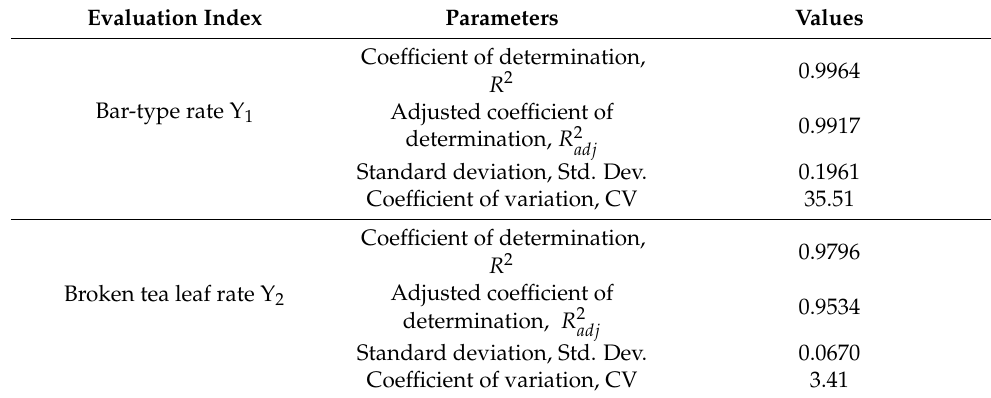
Table 6. Reliability analysis of the model.